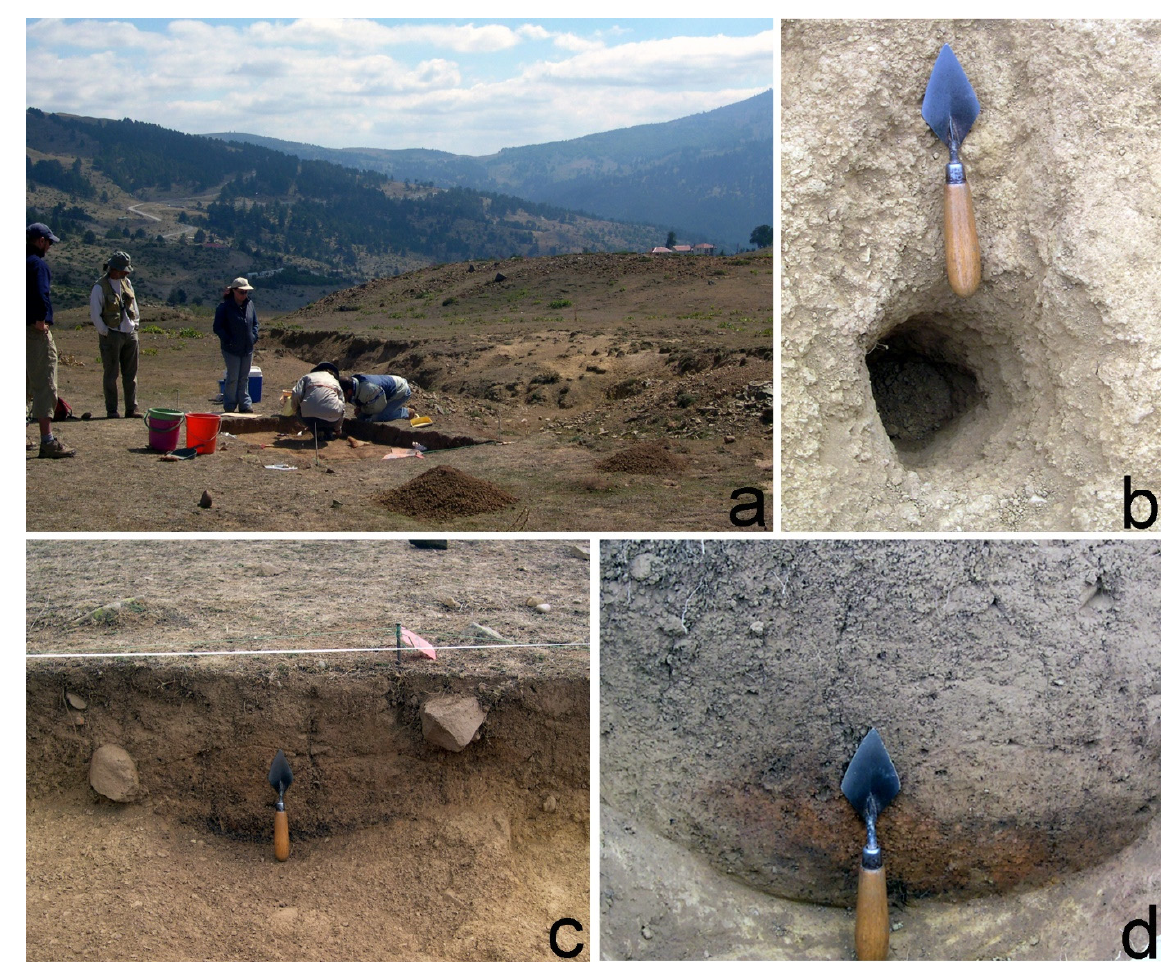
Figure 24. Historical Camp (HC): excavations underway in the seventh-century AD site. The 2 × 3 m test trench ( a ), inclined posthole ( b ), shallow burning pits or fireplaces with charcoals of small juniper branches ( c , d ), the second of which has been radiocarbon-dated to 1414 ± 18 BP (DEM-2586) (photographs by P. Biagi, 2006).